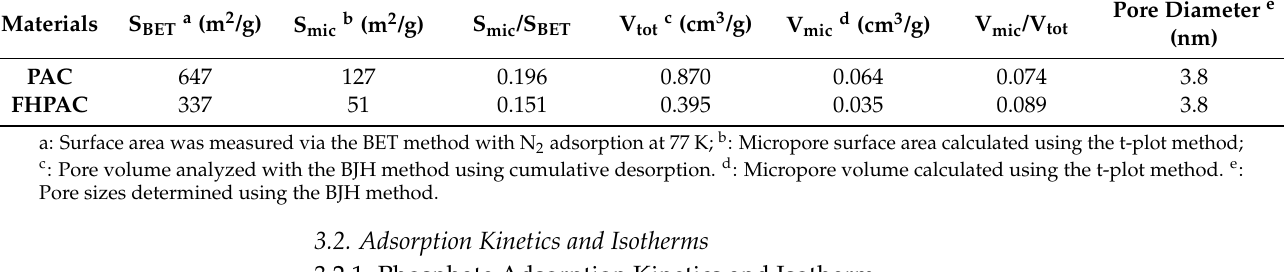
Table 1. Surface area and porosity analysis of PAC and FHPAC.